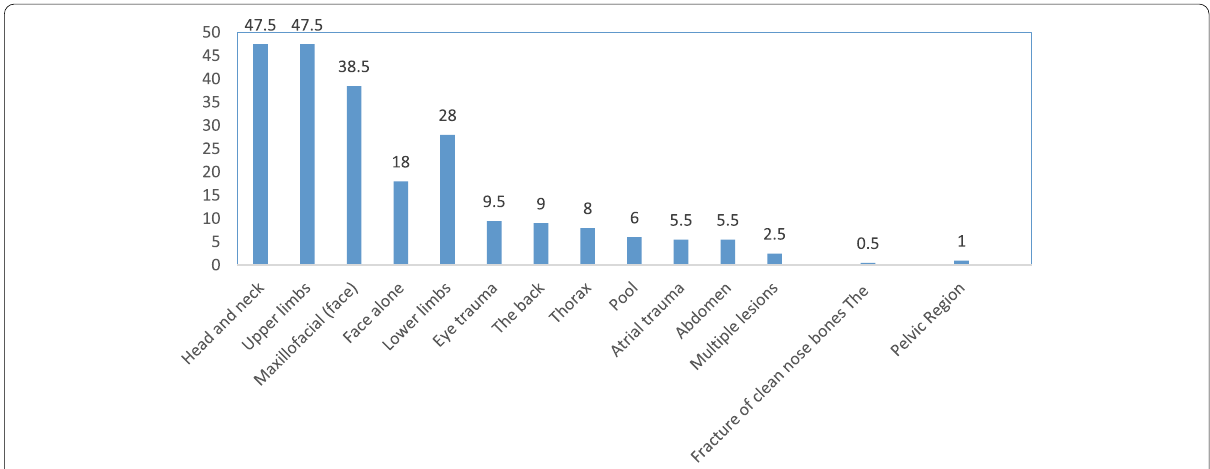
Fig. 2 The site of injuries among the women examined. (Several anatomical regions can be affected in the same trauma victim)